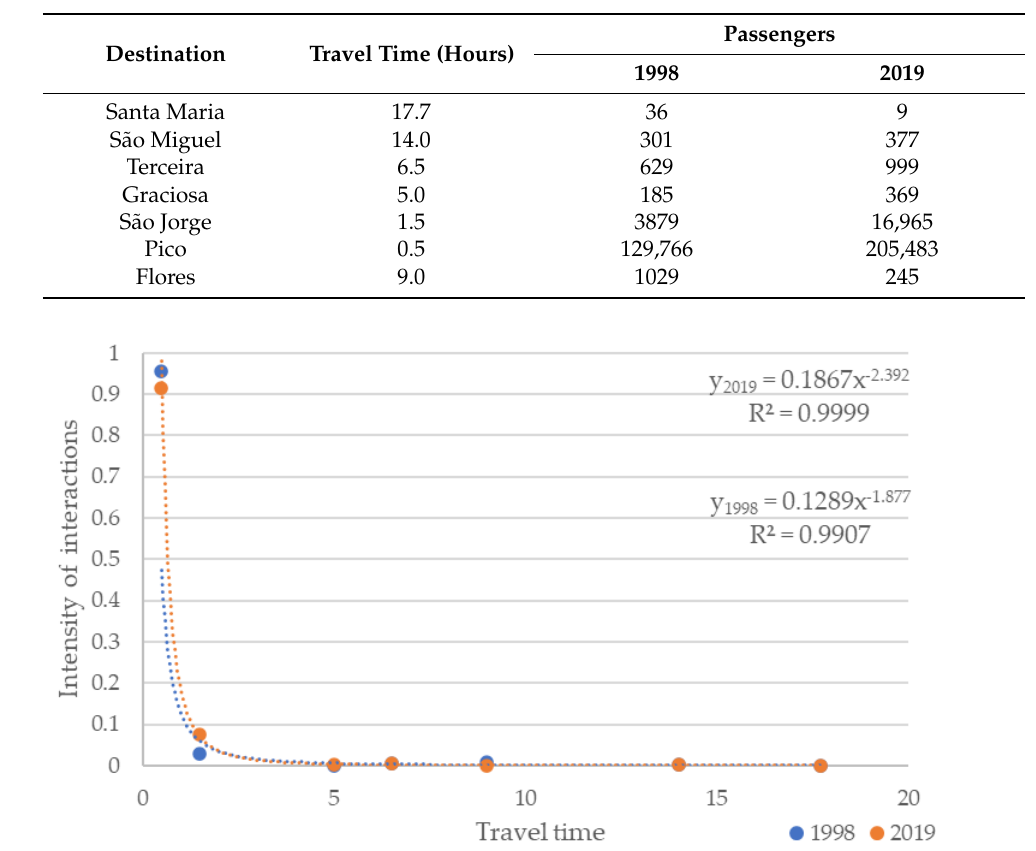
Figure 2. Intensity of interactions and travel time to Faial Island from the rest of the archipelago — for 1998 and 2019. 1998 and